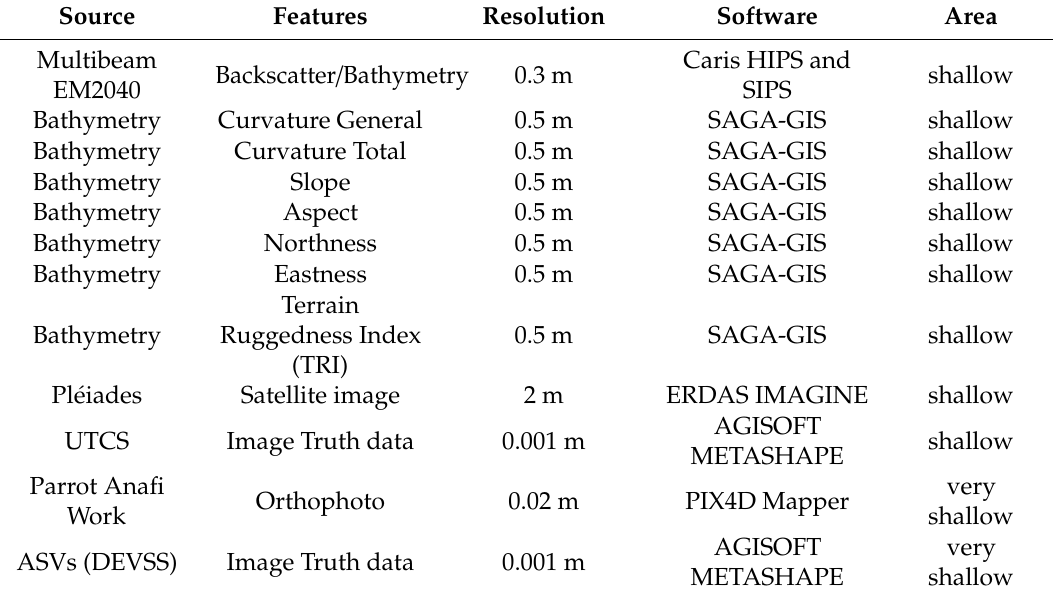
Figure 8. Workflow of the processing steps developed in this study to create the seabed map classification of Cirella Island marine habitats (see Figure 10). Table 2. Multidata source variable and list of extracted secondary features of the bathymetric and backscatter data.